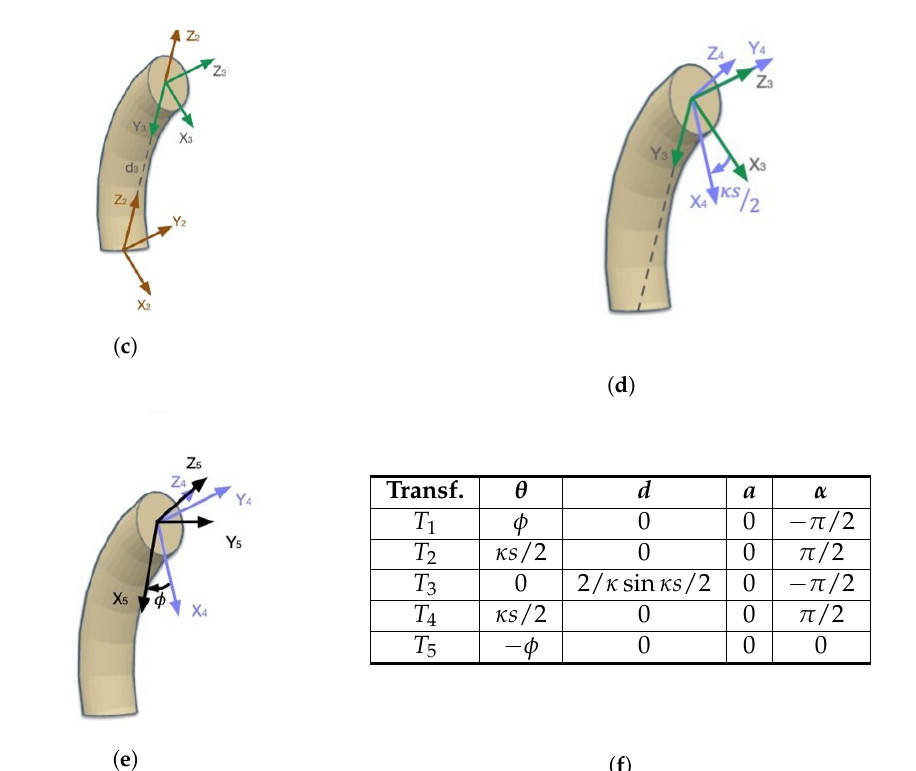
Figure 10. Application of Denavit–Hartenberg’s method to a robotic section of constant curvature. ( a ) T 1 . ( b ) T 2 . ( c ) T 3 . ( d ) T 4 . ( e ) T 5 . ( f ) Section’s parameter for Denavit–Hartenberg’s